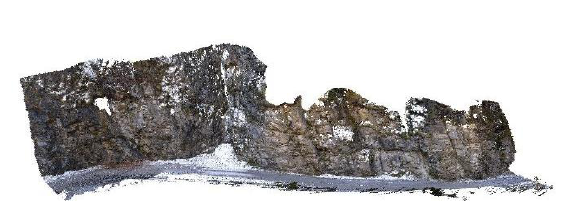
Figure 7. Example of "vertical" terrestrial dense point